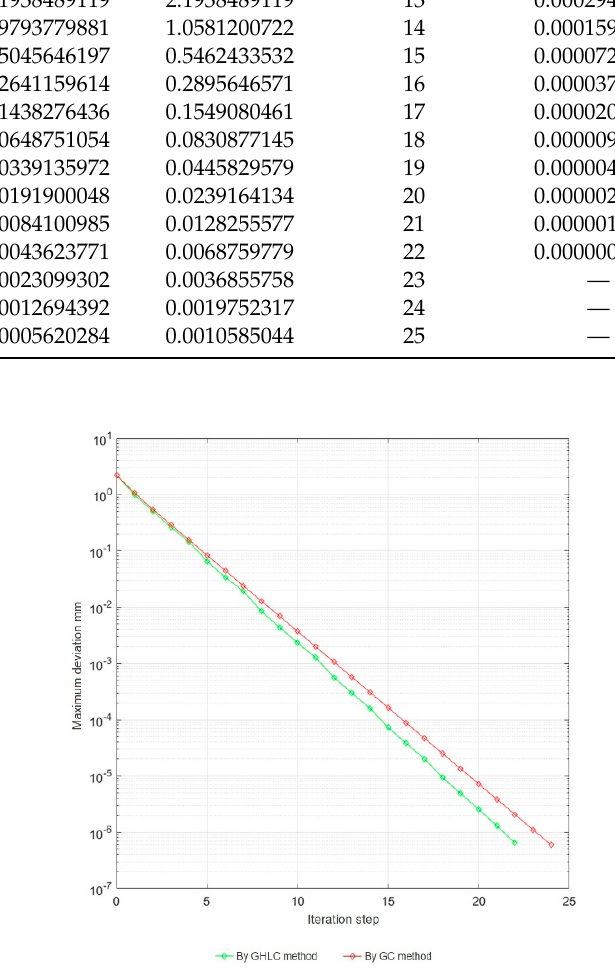
Figure 10. The maximum deviations varying with the iteration steps.